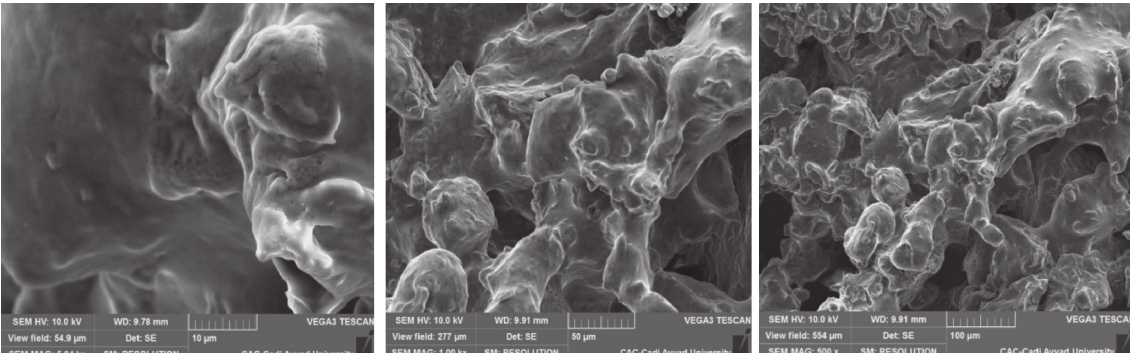
Figure 1: Scanning electron microscopy (SEM) images of SCP.